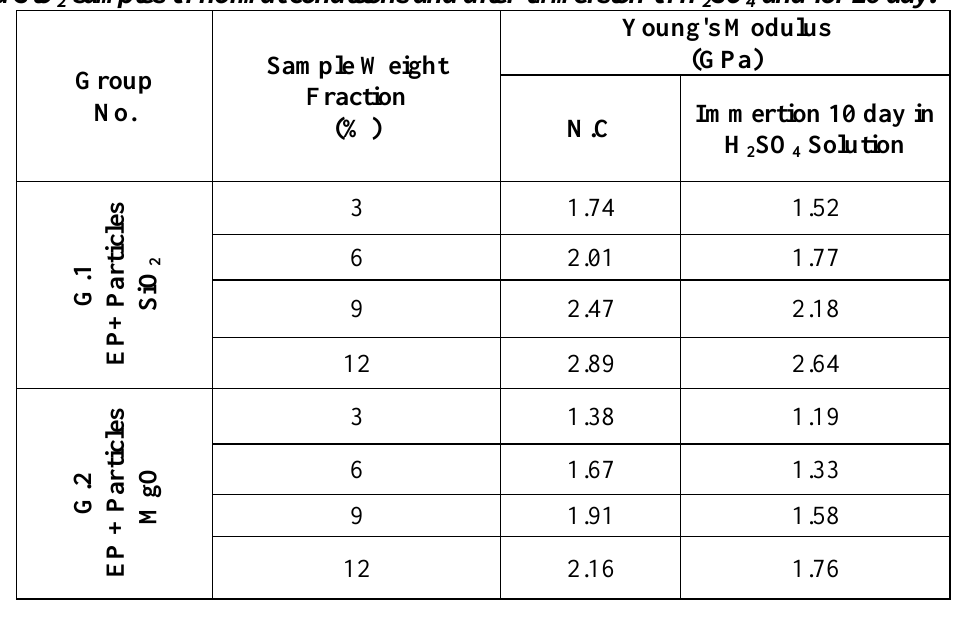
Table 3: The relationship between the Young's modulus and the weighted fracture of MgO and SiO samples in normal conditions and after immersion in H 2